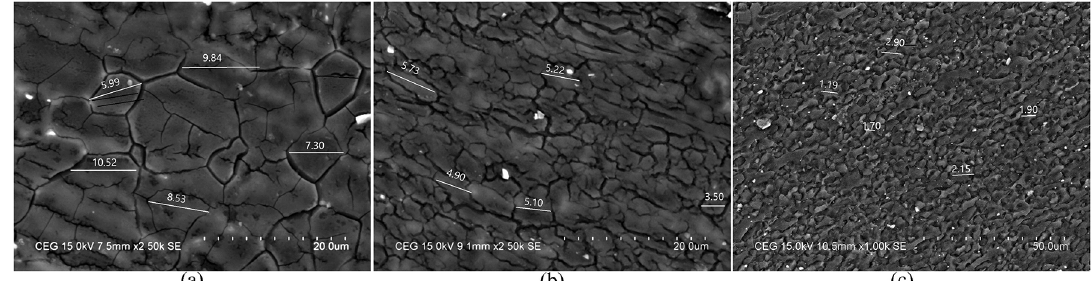
Figure 10. Effect of scroll tool pin profiles on SFSP zone SEM images (Rotational Speed: 1000 rpm) (a) Scrolled Cylindrical, (b) Scrolled Stepped Cylindrical, (c) Scrolled Stepped Square mode exists and larger voids representing lower